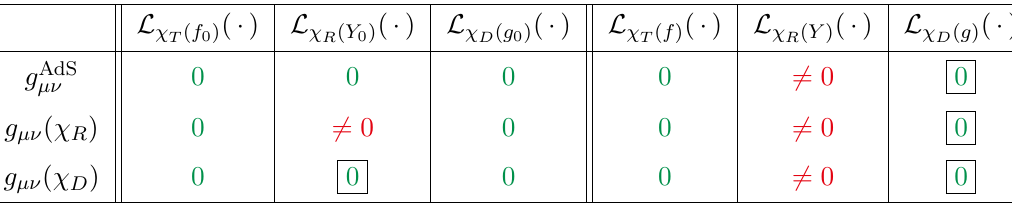
Table 7 . Action of the vectors χ p with p = T, R, D on the bulk metric, where all the quantities in this table are evaluated at ρ = 0 . We add a box on the entries of this table that do not agree with the boundary CFT results, given in the first six columns of table 5. Note that if we restrict to the ordinary supertranslations and superrotations BMS transformations, the bulk and boundary results match